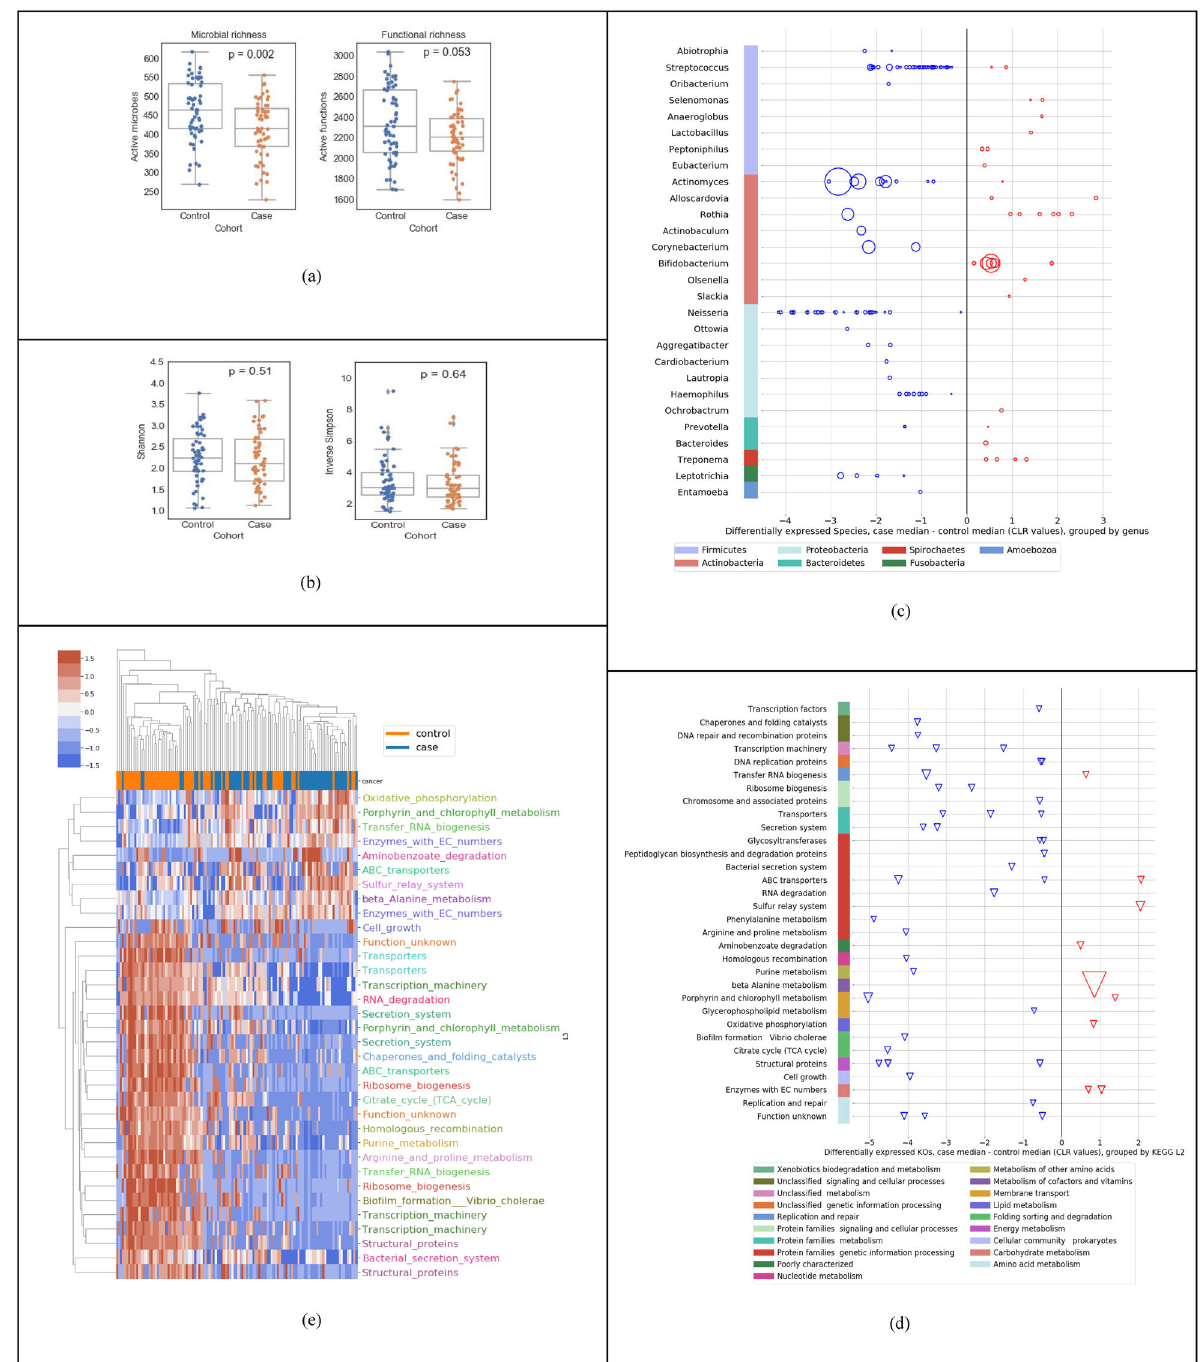
Fig. 1 Descriptive statistics of salivary metatranscriptome of the high-risk population (Cohort A in Table 1). a Species richness; control median 463, case median 415 and function richness; control median 2306, case median 2205. b Shannon diversity index; control mean 2.25, case mean 2.20; and Inverse Simpson diversity index; control mean 3.41, case mean 3.26. c Using Mann – Whitney U tests and at least twofold difference in means (0.69 in CLR space), 139 differentially expressed species (at p < 0.05) up- or downregulated (red and blue respectively) in cases relative to controls, organized by genus and phylum (median difference in CLR values); the size of the bubble is inversely proportional to the p value. d Using Mann – Whitney U tests and at least twofold difference in means (0.69 in CLR space), 49 differentially expressed KOs (at p < 0.05) up- or downregulated in cases relative to controls, organized by KEGG level-3 and level-2 functional groups; the size of each triangle is inversely proportional to its p value e Clustermap using Euclidean distance of CLR transformed sum(transcripts per million) data for active function (KO) features signi fi cant by Mann – Whitney U tests. Features are shown with corrected p values < 0.01 and median CLR differences between the cohorts of greater than 0 or less than − 1. KOs are color coded by their KEGG level-3 functional